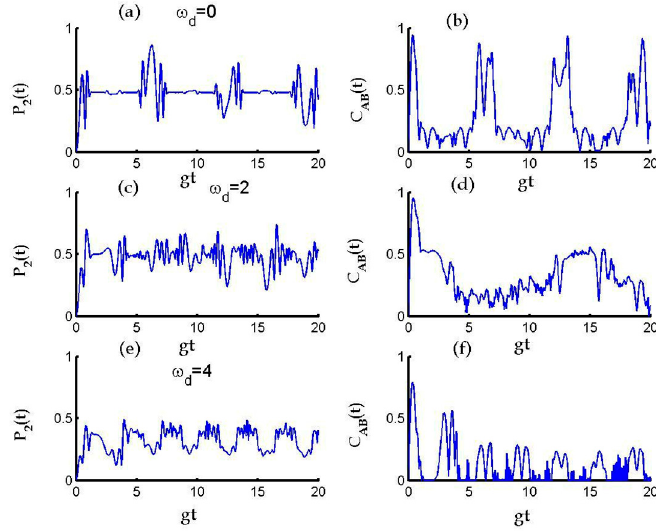
Figure 5. (Color Online) The probability and entanglement are plotted versus the dimensionless time gt for various values of the energy detuning for two-photon transition ( l = 2) in the presence of atomic motion effect G ( t ) = g sin 2 ( t ) with | α | 2 = 10. ( a , c , e ) display the variation of the population for a single-excitation with the time; ( b , d , f ) present the evolution of the concurrence of the donor-acceptor state during the time evolution. ( a , b ) is for ω d = 0; ( c , d ) is for ω d = 2; and ( e , f ) is for ω d = 4.